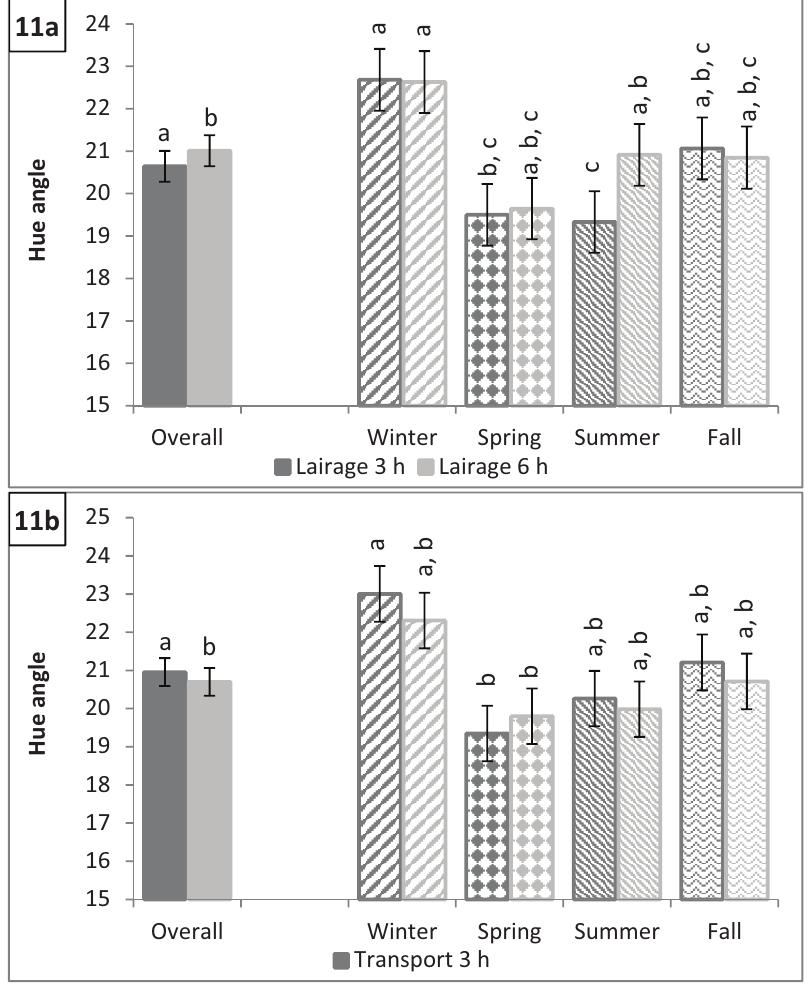
Figure 11. Hue angle ( a ) by lairage duration (P = 0.002) and by season × lairage duration (P < 0.0001) and ( b ) by transport duration (P = 0.03) and by season × transport duration (P = 0.002). Values with different letters differ by P <